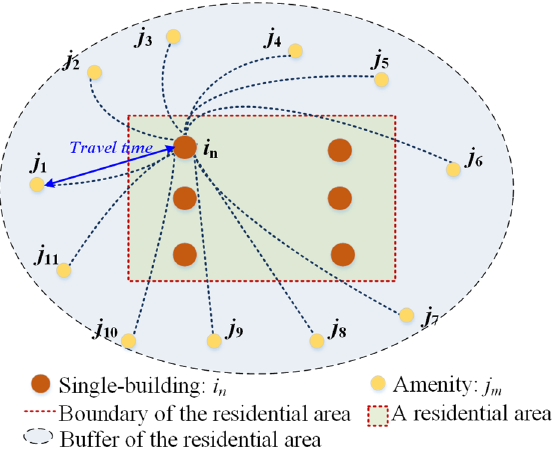
Figure 1. Relation between an origin (single building i n ) and a destination (amenity j m ).